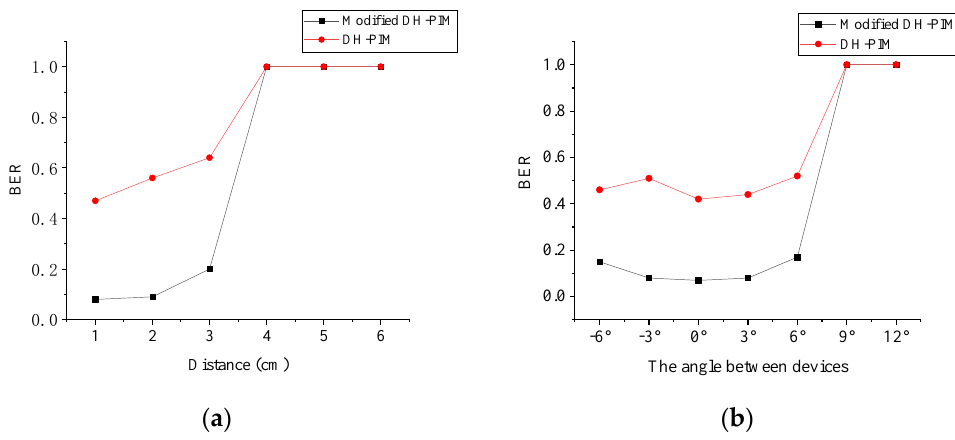
Figure 11. ( a ) BER under different distances in uplink. ( b ) BER under different angles in uplink.